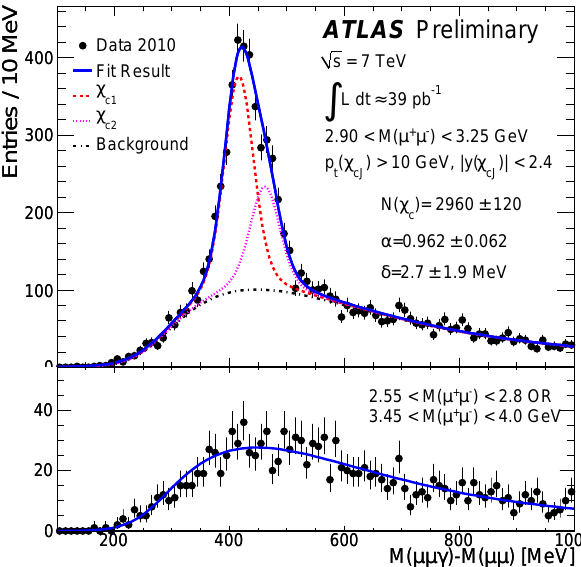
Fig. 6. The results of a simultaneous fit to the signal region (top) and background ( J /ψ sideband) region (bottom), showing signals of χ c 1 and χ c 2 mesons reconstructed (via calorimetry measure- ment) through their radiative decays to J /ψ + γ , viewed as a func- tion of the invariant mass di ff erence between the µµγ and µµ sys-